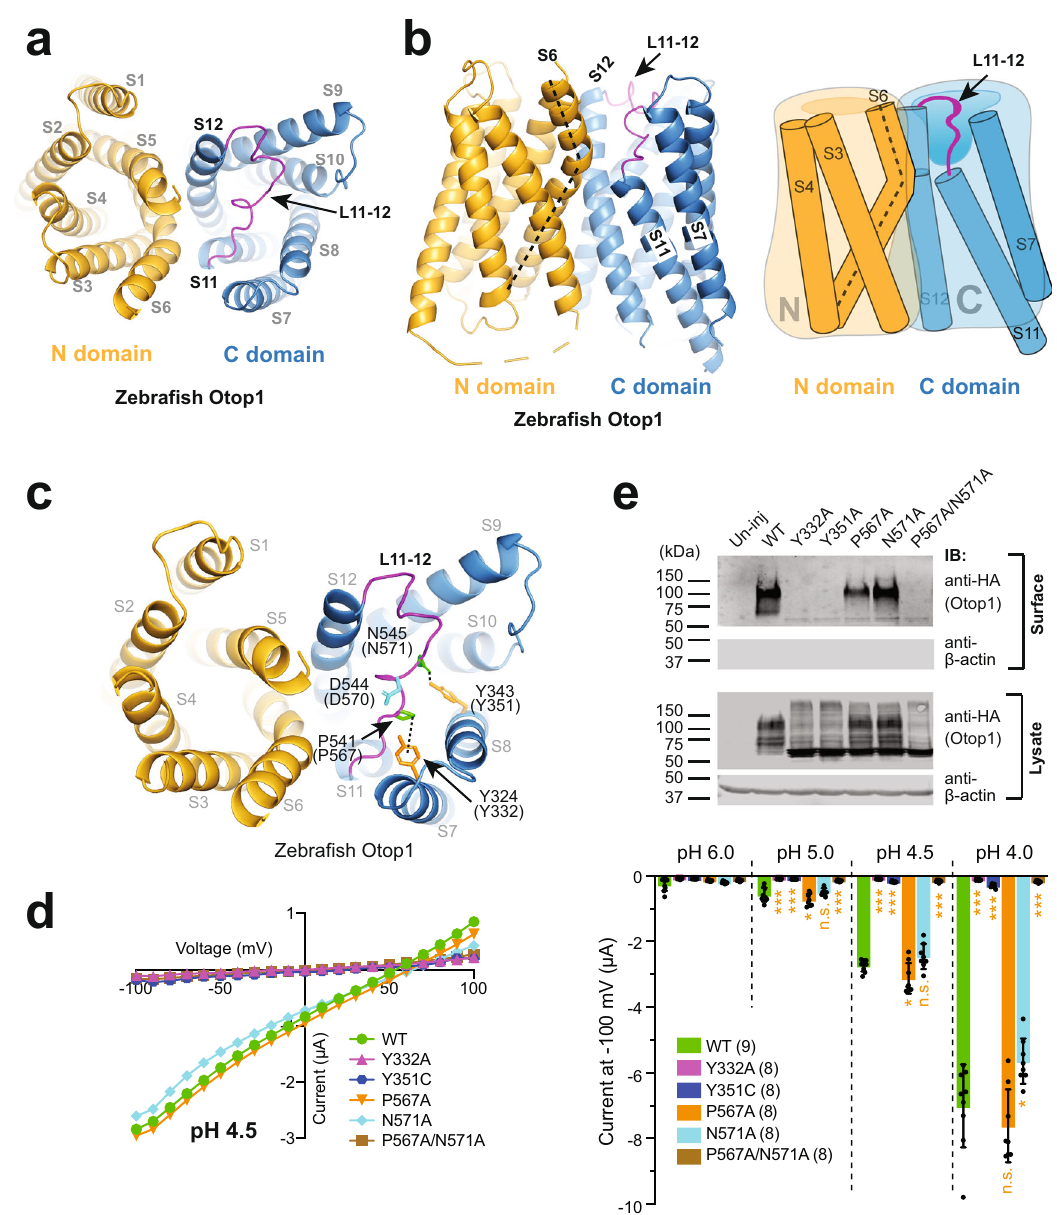
Fig. 4 L11 – 12 is structurally and functionally essential for the Otop1 channel. a Top view of the cryo-EM structure of the zebra fi sh Otop1 (PDB 6NF4) 23 , showing that L11 – 12, which is in purple, crosses the center of the C pore. b Side view of the cryo-EM structure of the zebra fi sh Otop1 (left) and a cartoon (right) show the gap between S7 and S12 in the top 1/3 portion of the C barrel caused by the relatively lower position of S11 in the transmembrane part of the Otop1 structure. L11 – 12 extends upwards and crosses the pore to reach S12. S6 is bent (indicated by dashed lines) to further leave the gap open for access. c Top view of the cryo-EM structure of the zebra fi sh Otop1 to show the two very conserved tight interactions (shown in the black dotted line) that anchor L11 – 12 in the right position. Side chains of the four residues involved in the interactions, as well as D544 (D570 in human), are shown as sticks. Residue numbers are indicated in both zebra fi sh and human (in parenthesis) sequences. d Left: the representative I – V curves of the indicated WT and mutant human Otop1 channels. Right: the scatter plot and bar graph showing the currents of the indicated channels recorded at − 100 mV at the indicated pHs. Data in the bar graphs are presented as mean ± SD. Currents of the mutants were compared to that of the WT with Student ’ s t -test (* P < 0.05, *** P < 0.001, n.s.: no signi fi cance). Oocyte numbers for scatter plots and bar graphs are indicated in parentheses. e Western blot showing the overall expression (in lysate samples) and surface expression of indicated WT and mutant channels. The surface proteins were puri fi ed by surface Further analysis of the position of L11 – 12 in the zebra fi sh Otop1 (Fig. 4c). All residues are highly conserved among Otop 1, 2, and 3 cryo-EM structure 23 led us to recognize two highly conserved proteins in distinct species, and both interactions are observed in all interactions that anchor L11 – 12 to its current position in the three published cryo-EM structures of Otop1 and Otop3 structure. The fi rst is the CH/ π interaction between P541 (P567 in proteins 22,23 . These two tight interactions anchor L11-12 at the center of the top opening of the C domain (Fig. 4c). Apart from human Otop1) in L11 – 12 and Y324 (Y332 in human Otop1) in S7. maintaining the structure of L11 – 12, they may also play a key role in The second interaction is a hydrogen bond that hooks N545 (N571 protein assembly by stabilizing the top portions of S7 and S8. To test in human Otop1) in L11 – 12 and Y343 (Y351 in human Otop1) in S8